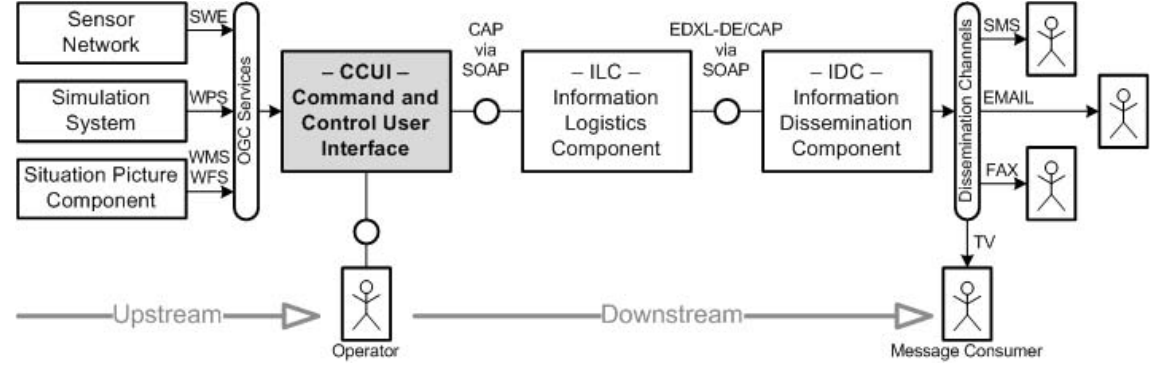
Fig. 4. DEWS architecture simplified (Lendholt and Hammitzsch, 2011a) with